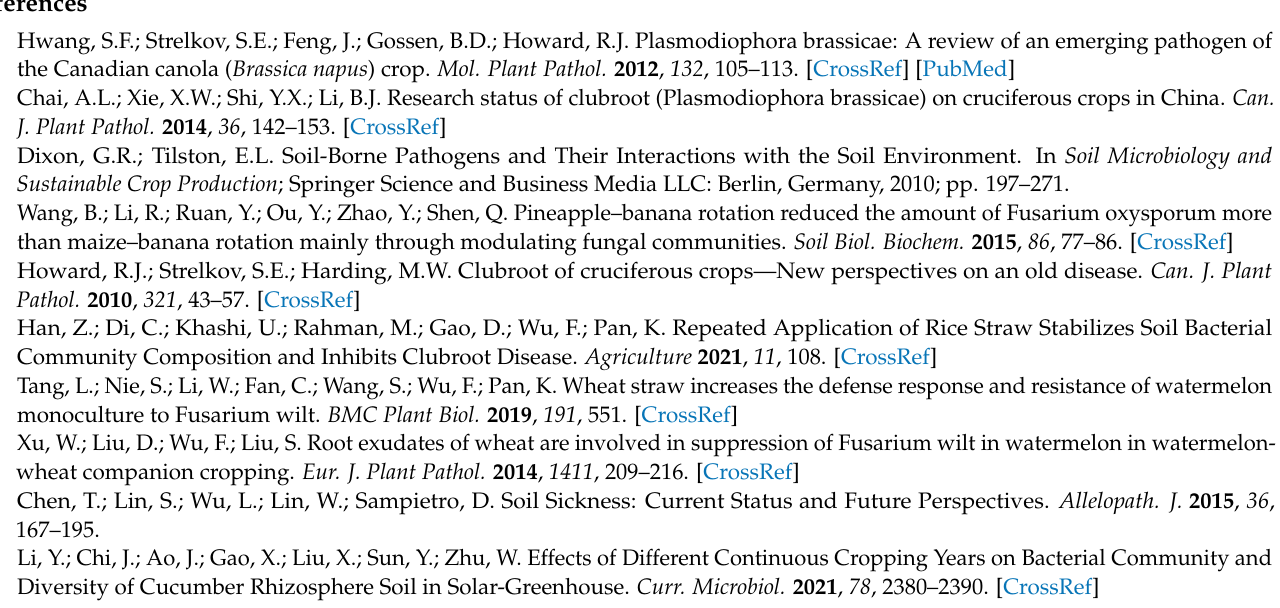
Table S6: Mantel test analysis of soil properties and bacterial and fungal community structures of the preceding crops during